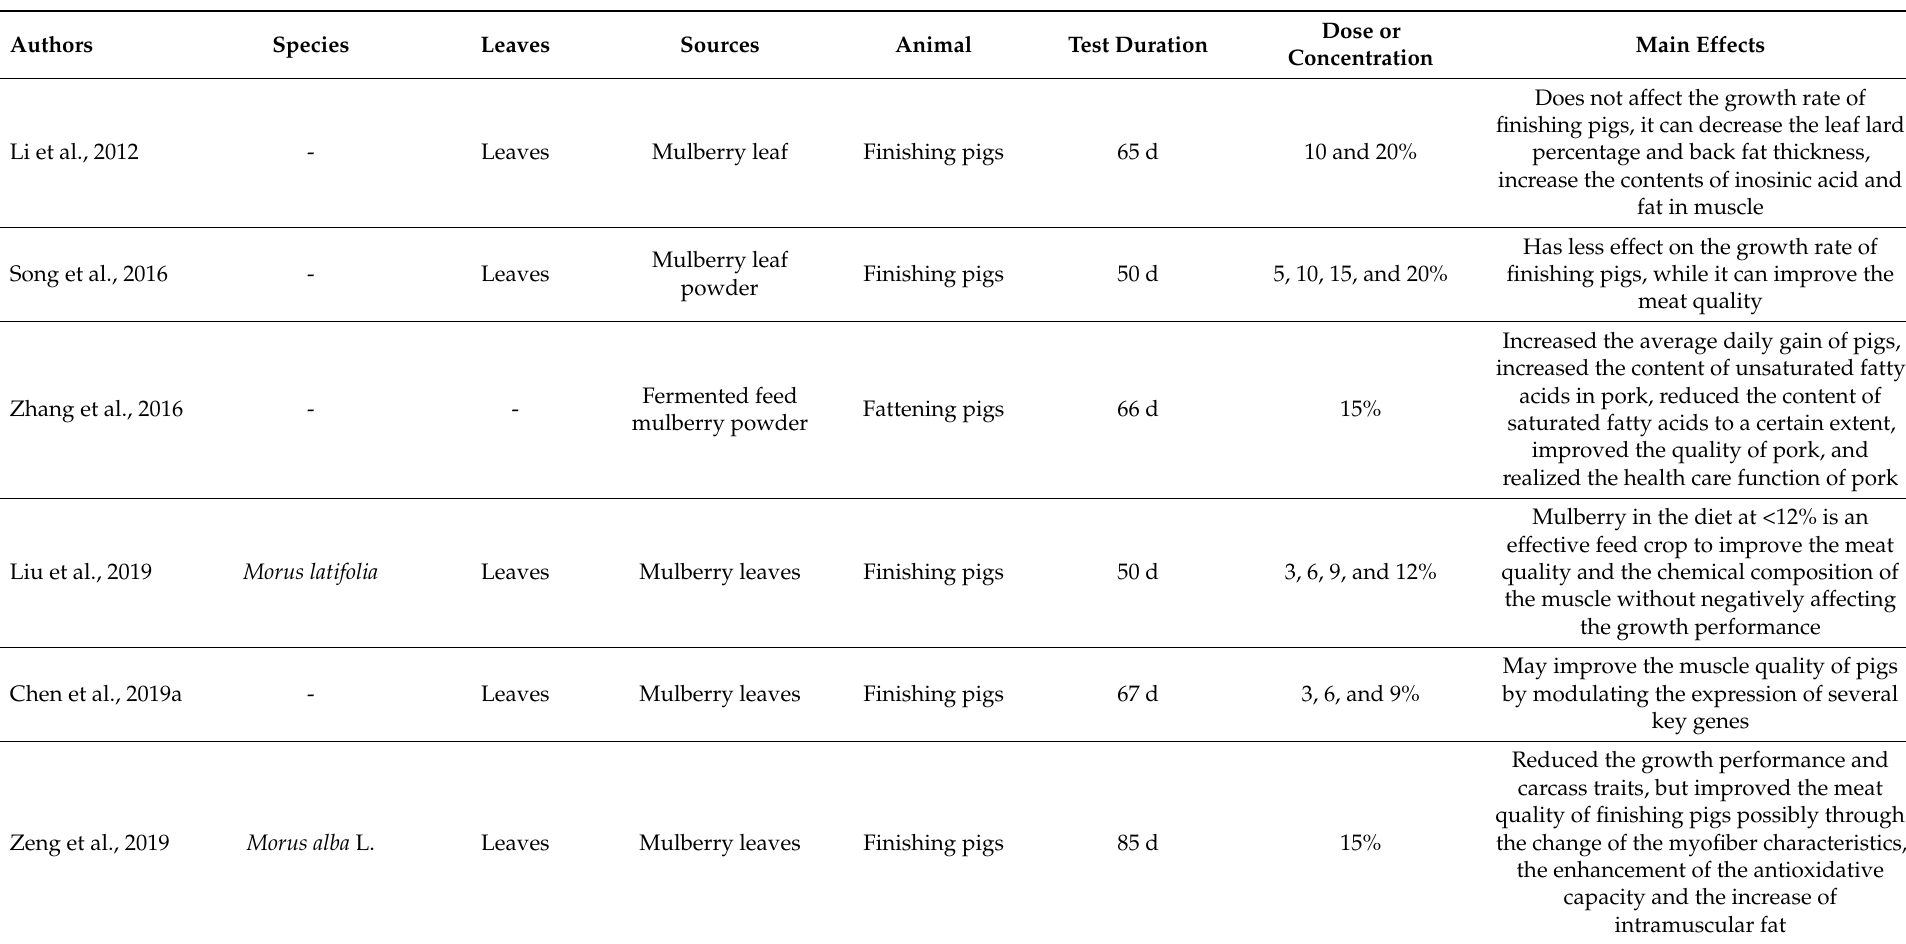
Table 4. The application of mulberry tree extracts on